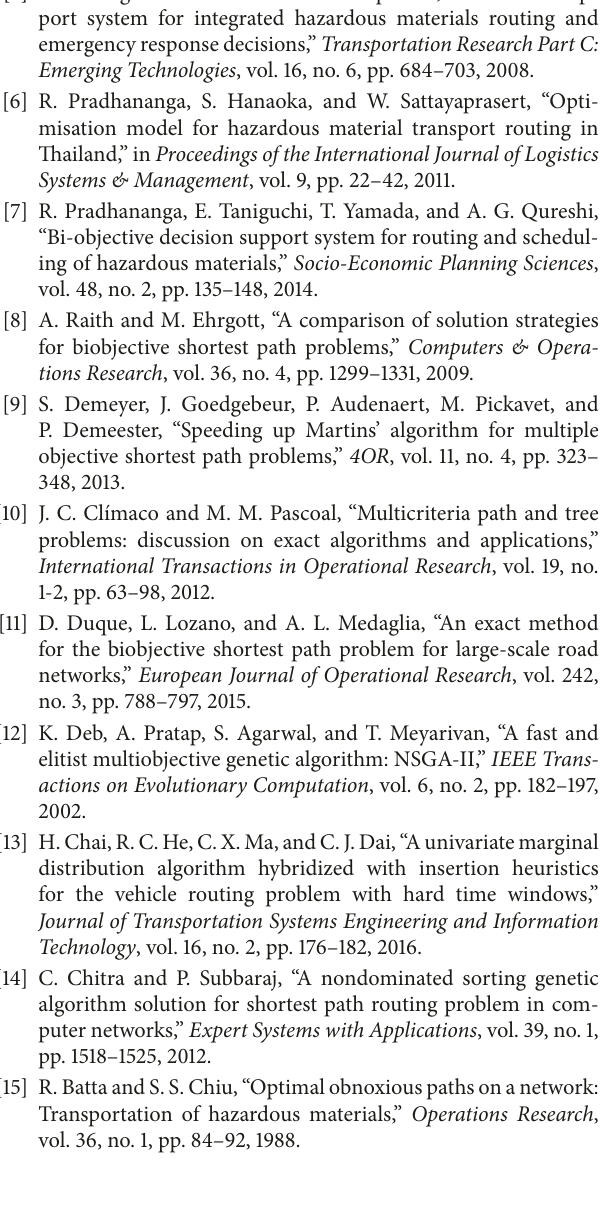
Table 10: Vehicle scheduling plan of plan